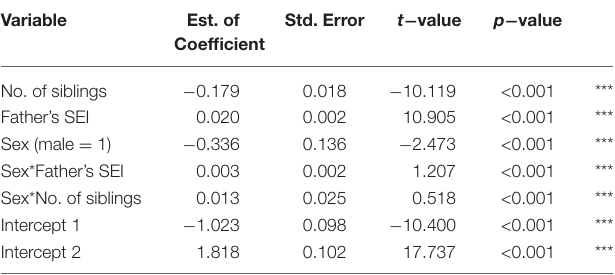
TABLE 5 | Effects of father’s SEI on parental ability to financially support college.